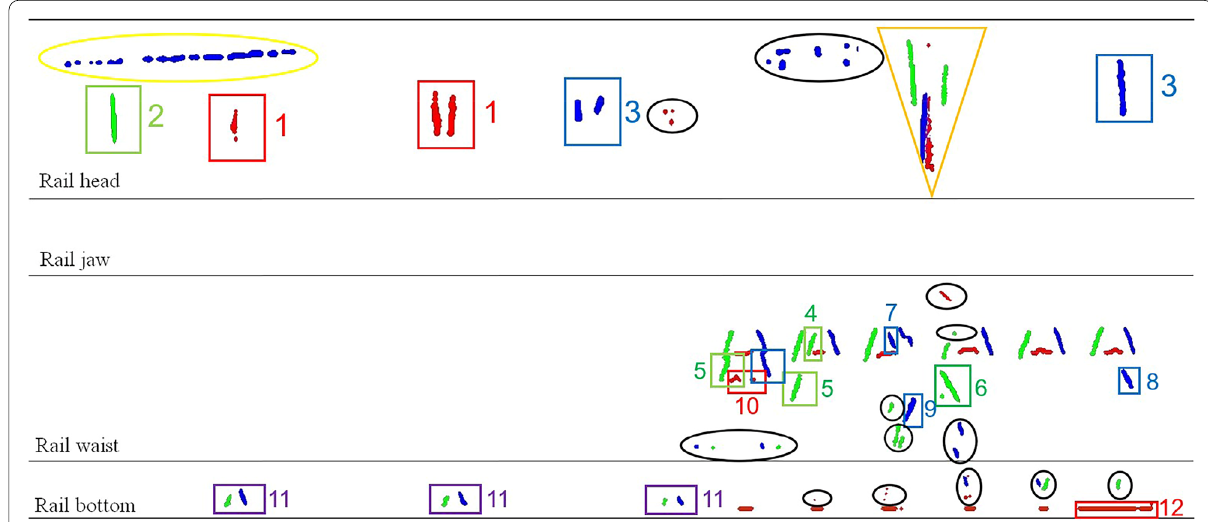
Figure 5 All kinds of defects and non-defects in the B-scan